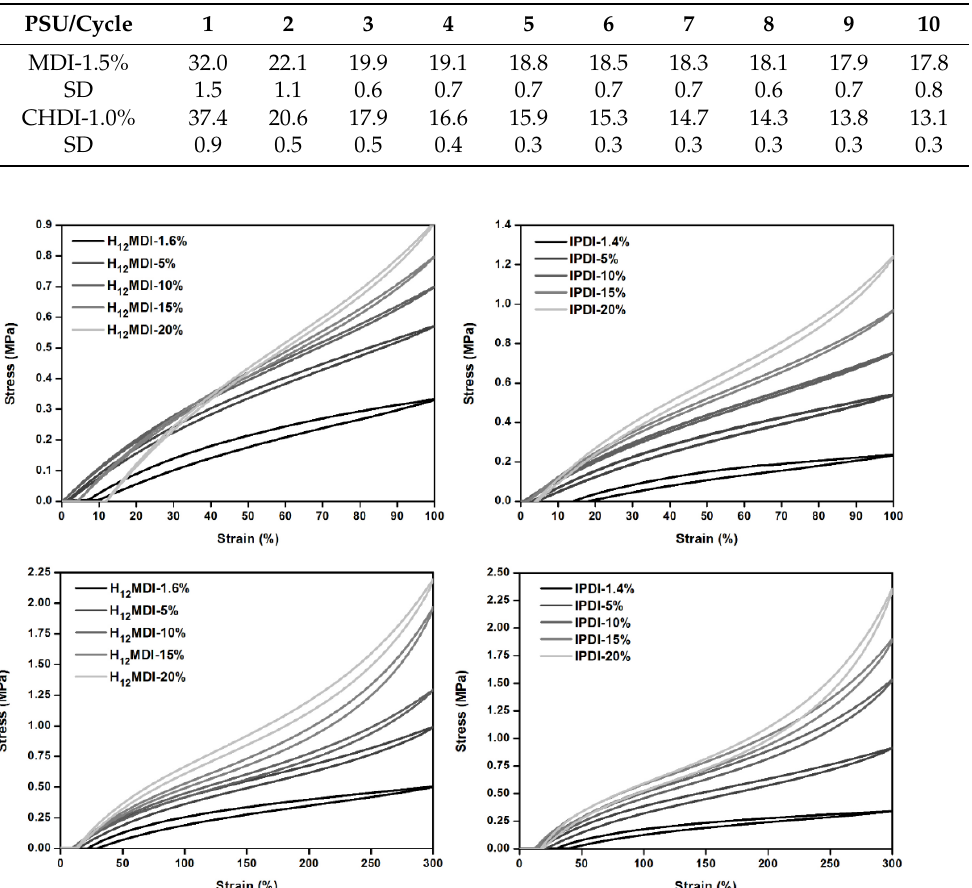
Figure A7. ( top ) 10th cycle hysteresis at 100% strain of PDMS-based polyurea-elastomers synthesized from H 12 MDI and IPDI comprising different HS contents from 1.6% (1.4%) to 20%. ( bottom ) 10th cycle hysteresis at 300% strain.